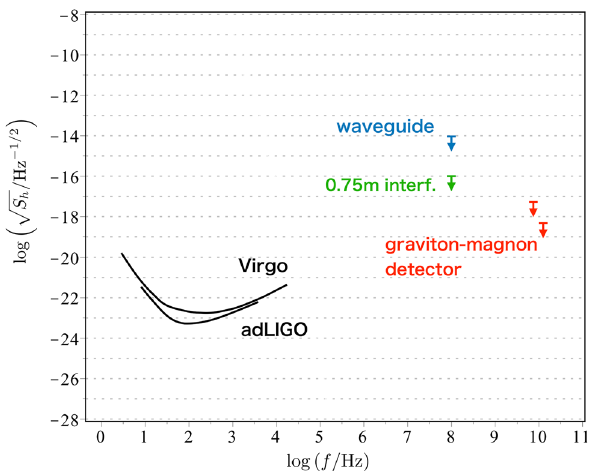
Fig. 1 Several experimental sensitivities and constraints on high fre- quency gravitational waves are depicted. LIGO and Virgo have a sensi- tivityaround10 2 Hz[14,15].Thebluecolorrepresentsanupperlimiton stochastic gravitational waves by waveguide experiment using an inter- actionbetweenelectromagneticfieldsandgravitationalwaves[34].The green one is the upper limit on stochastic gravitational waves, obtained by the 0.75 m interferometer [20]. The red color represents the sensi- tivity of the graviton–magnon